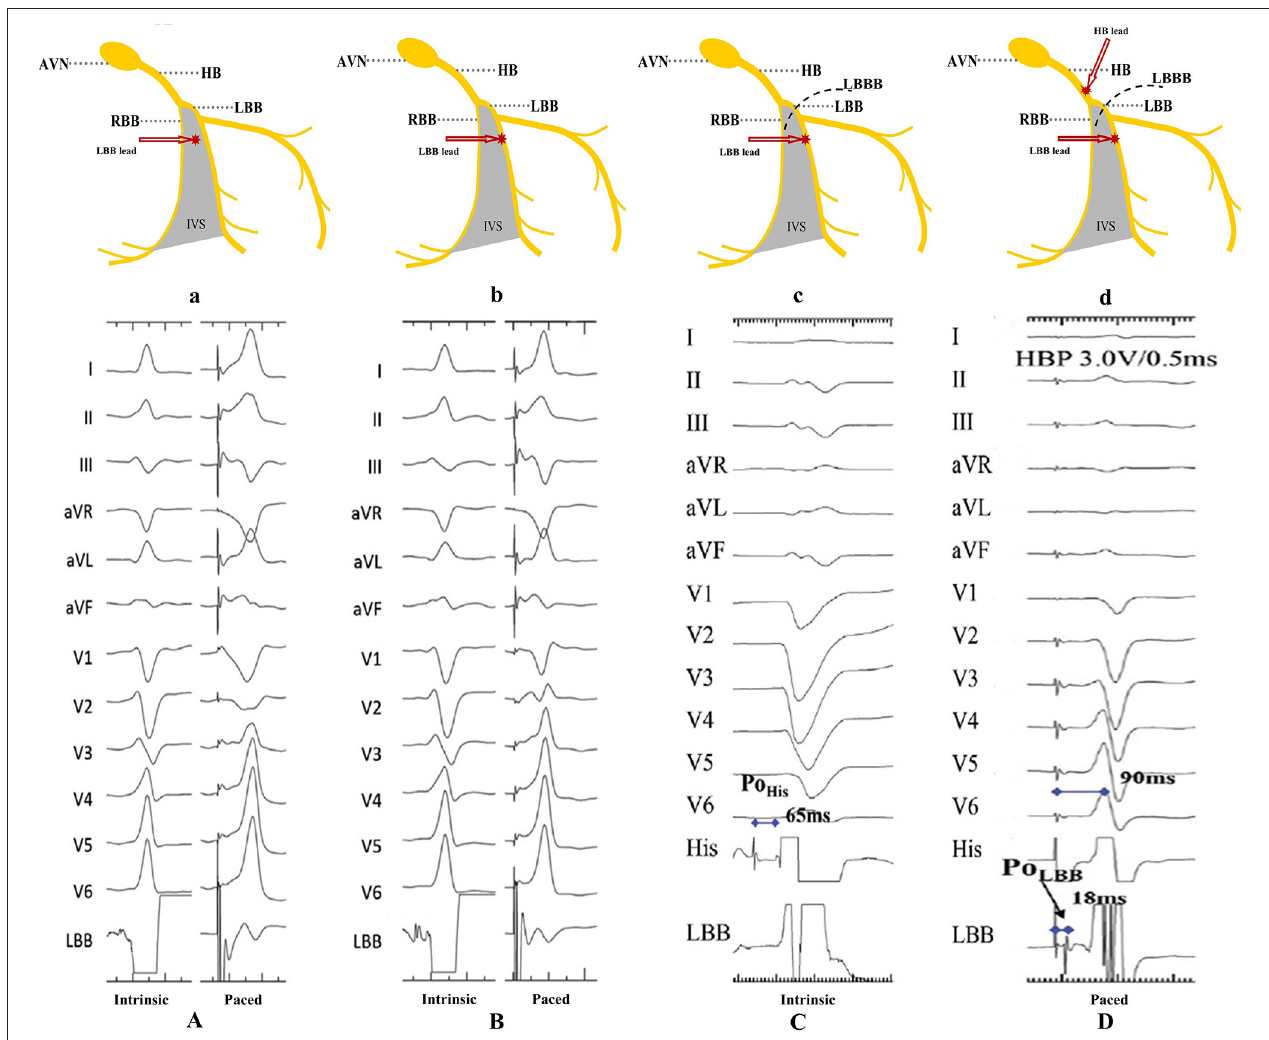
FIGURE 4 | Recording of the LBB potential. (A) The LBB potential can be recorded when the pacing lead helix is approaching the LBB. (B) The LBB potential becomes larger when the lead is closer to or at the LBB. (C,D) The LBB potential cannot be recorded in patients with LBBB, unless LBB is corrected by HBP (9). AVN, atrioventricular node; HB, His bundle; LBB, left bundle branch; LBBB, left bundle branch block; RBB, right bundle branch; IVS, interventricular septum; Po His , His potential; Po LBB , left bundle branch